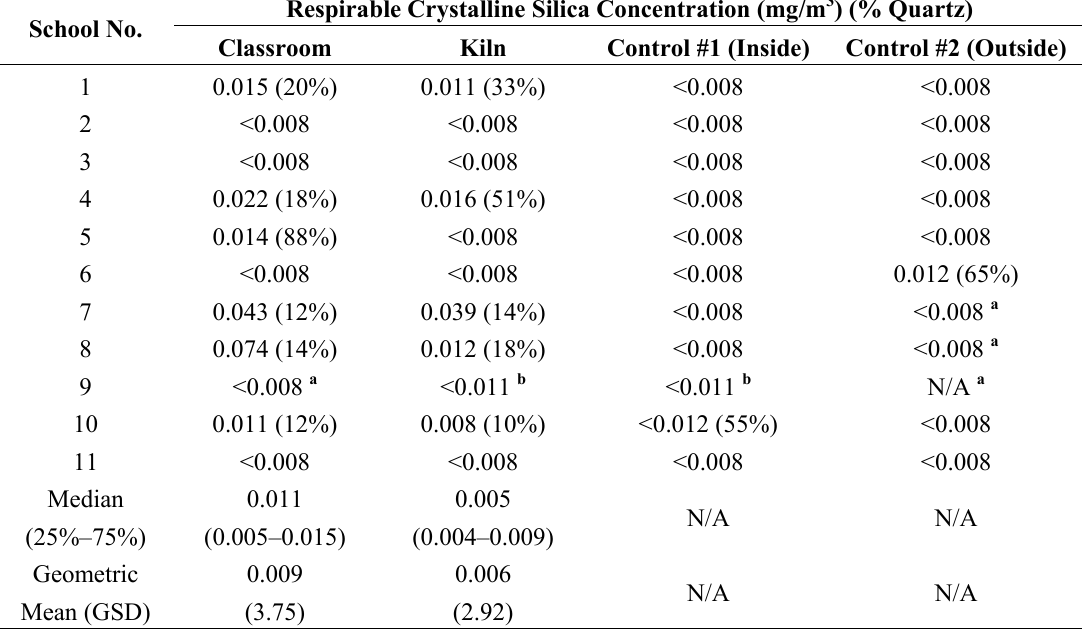
Table 2. Summary of results for respirable crystalline silica concentrations by location. School